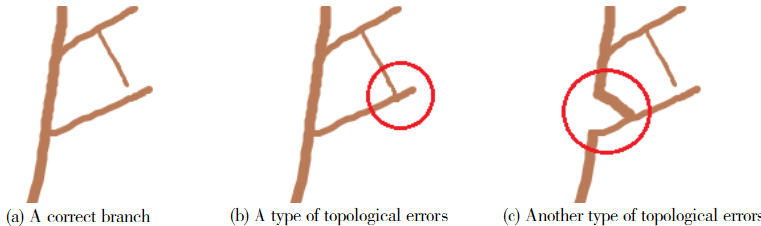
Figure 2. Two types of topological